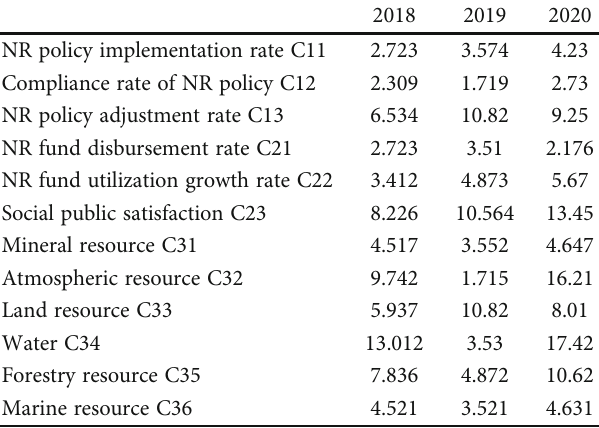
Table 4: Comprehensive score of NR assets outgoing audit